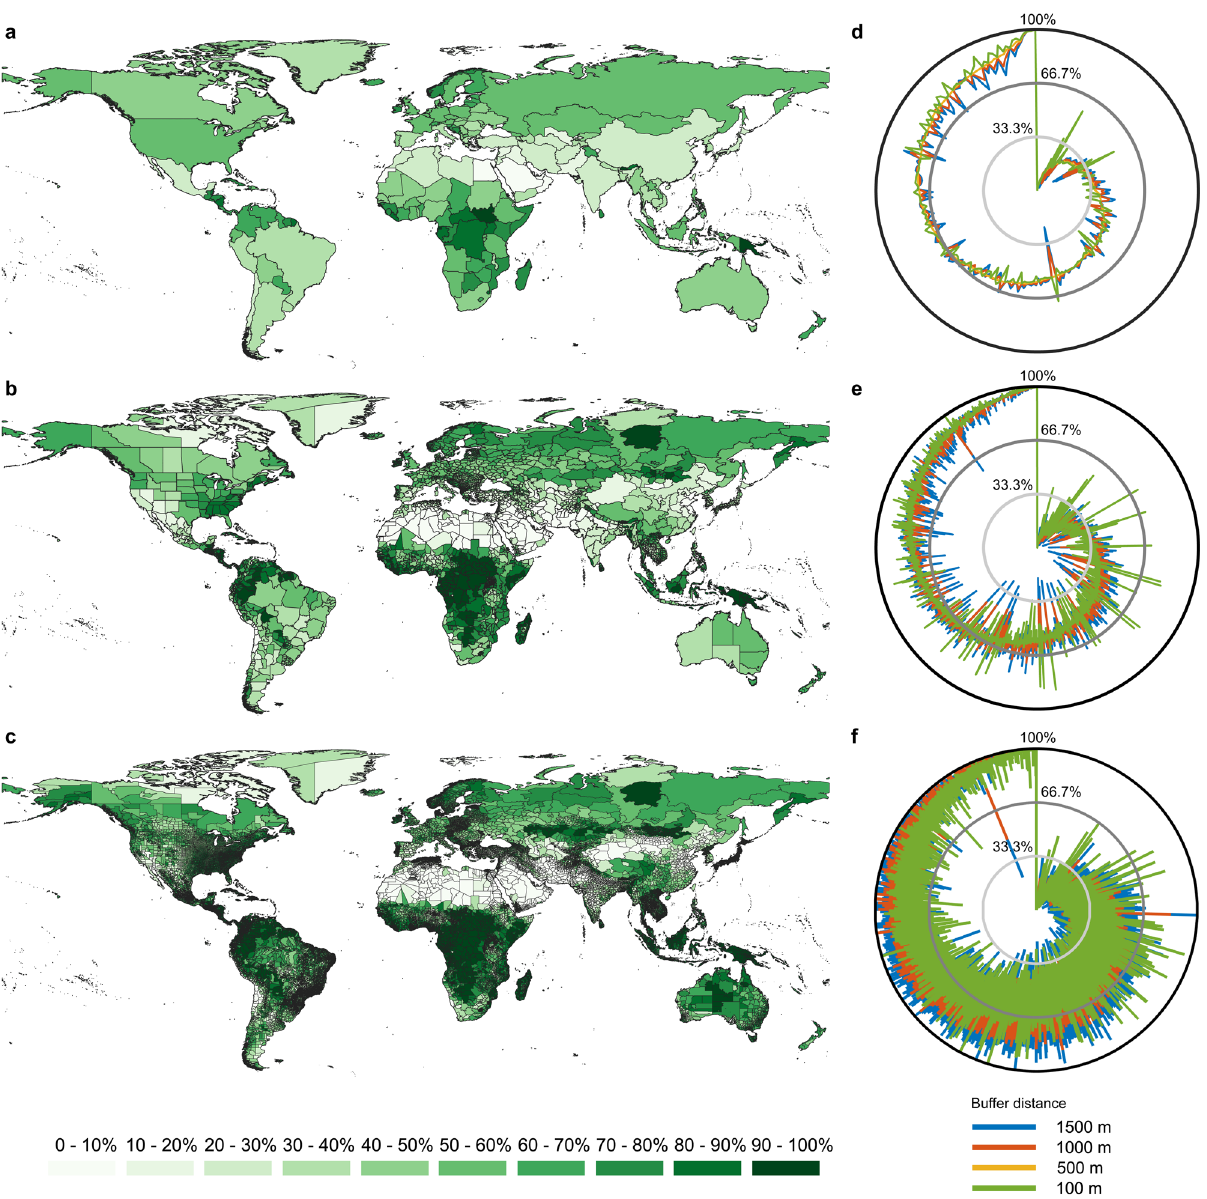
Fig.1|Multiscaleheterogeneitiesofhumanexposuretogreenspaceacrossthe globe. a – c Country-level, state-level, and county-level assessments of human exposure to greenspace using 500m buffer zones, respectively, with darker green colorsshowinghigherlevelsofgreenspaceexposure.Sensitivityofdifferentbuffer